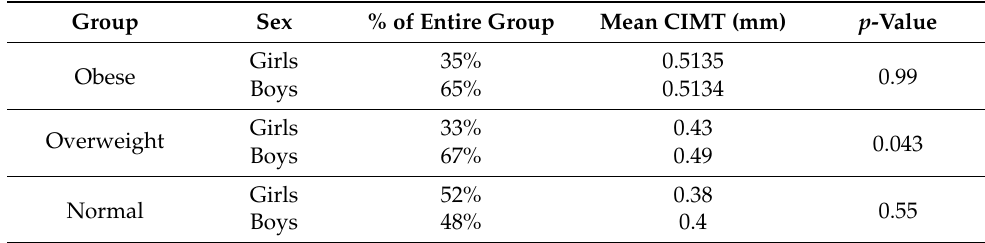
Table 2. CIMT with regard to